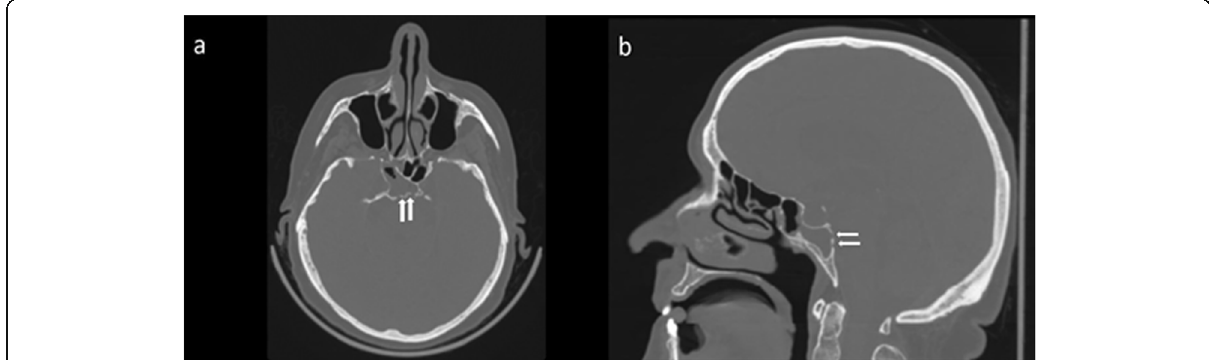
Fig. 1 Axial ( a ) and sagittal ( b ) reformatted computerized tomography on bone window reveals a fluid-filled pneumatized clivus with tiny bone defects at the posterior margin